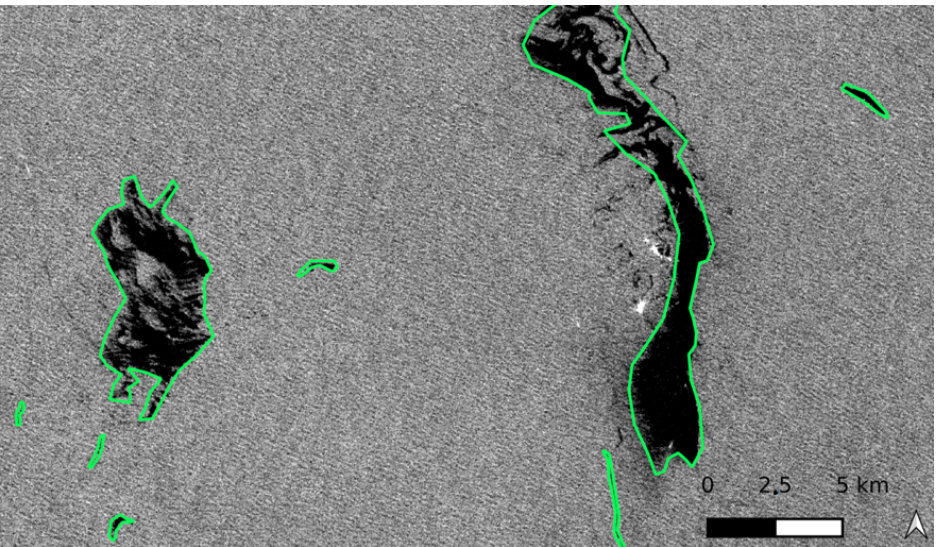
Figure 7. Example of slick annotation on a Sentinel-1 image on 21 January 2020 in the Nigeria area, where annotations are highlighted in